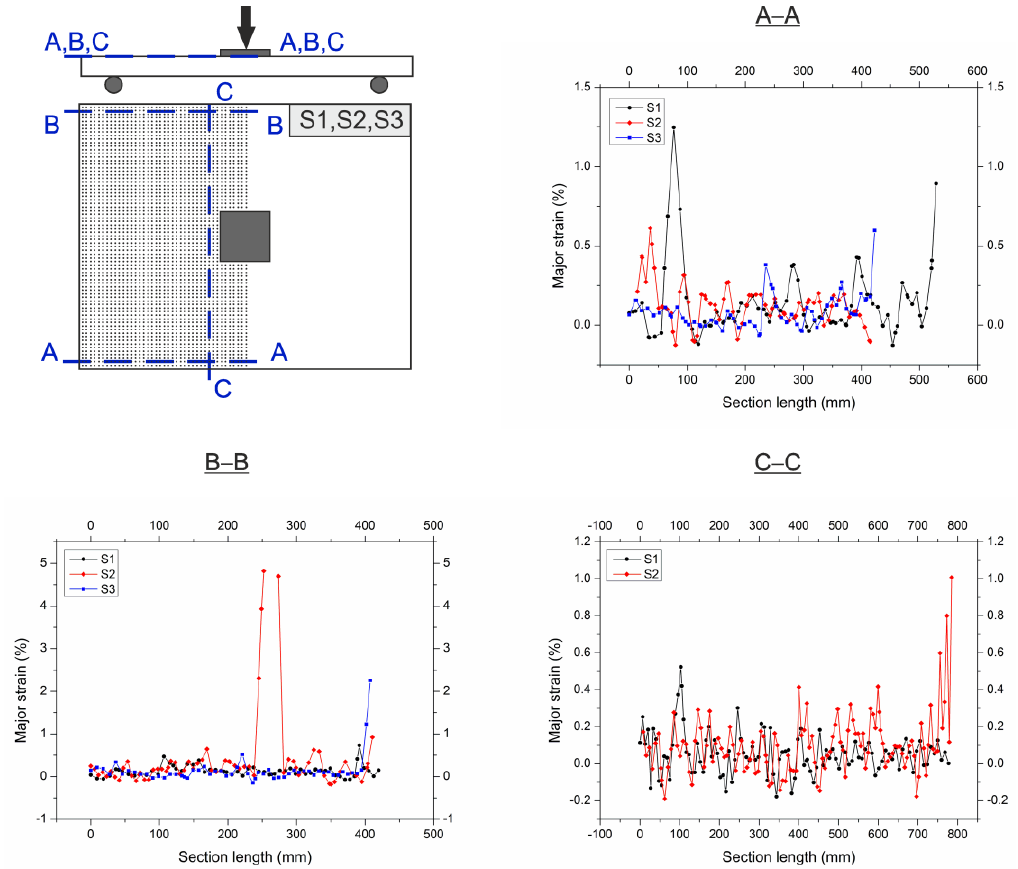
Figure 12. Major strains of slabs upper surface at peak load.